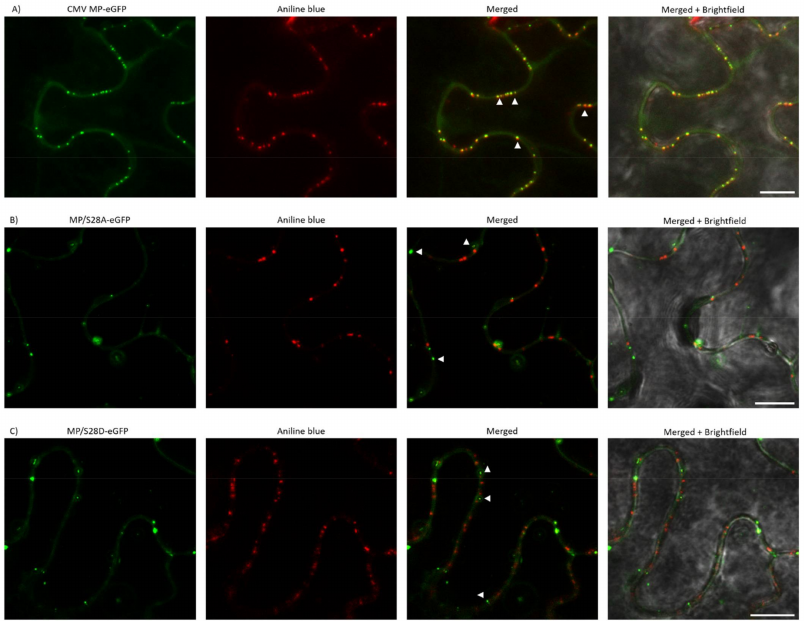
Figure 4. Subcellular localization of wild type and mutant MP-eGFP constructs on Nicotiana benthami- ana . ( A – C ) MP-eGFP and mutant constructs MP/S28A-eGFP and MP/S28D-eGFP were transiently expressed in N. benthamiana leaves. Aniline blue staining served as a plasmodesmata marker. Im- ages were taken 24–48 h after agroinfiltration using a confocal microscope. For better visualization, eGFP fluorescent and aniline blue images were false colored as green and red, respectively. Arrow- heads indicate the punctate structures. Scale bar: 10 µ